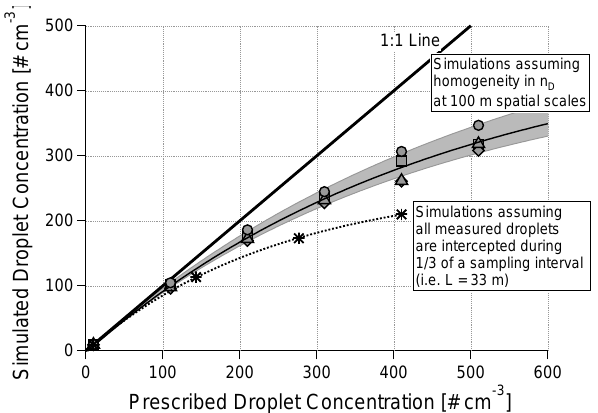
Fig. 13. Simulated droplet concentrations as a function of pre- scribed droplet concentrations. All droplet sizes exhibit roughly the same degree of undercounting. Sub-sample variability in droplet concentrations increases the undercounting